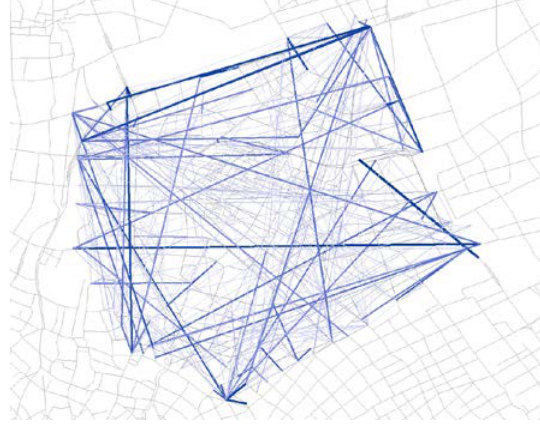
Figure 12. 10000 simulated ODs to approximate traffic flow